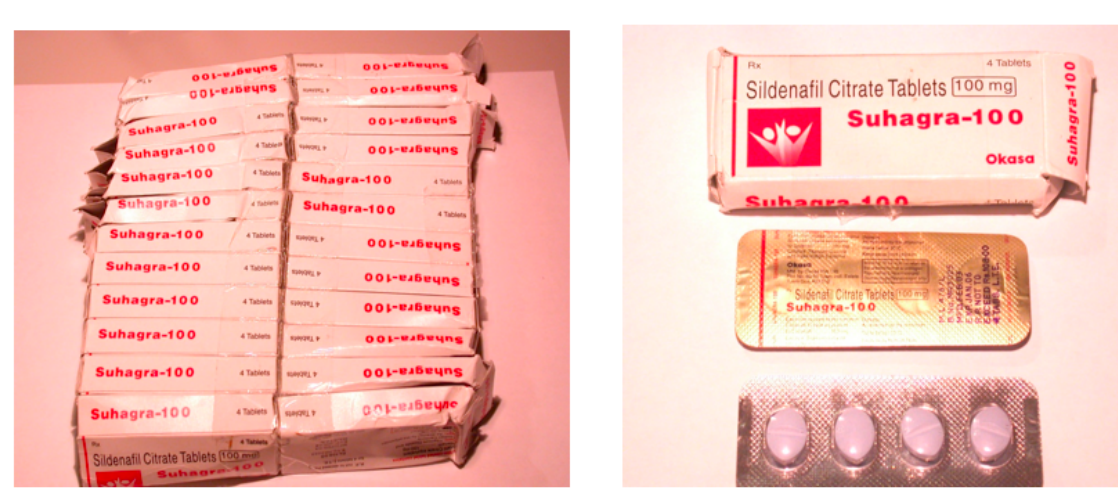
Figure 1. Generic sildenafil tablet obtained via the Internet without prescription